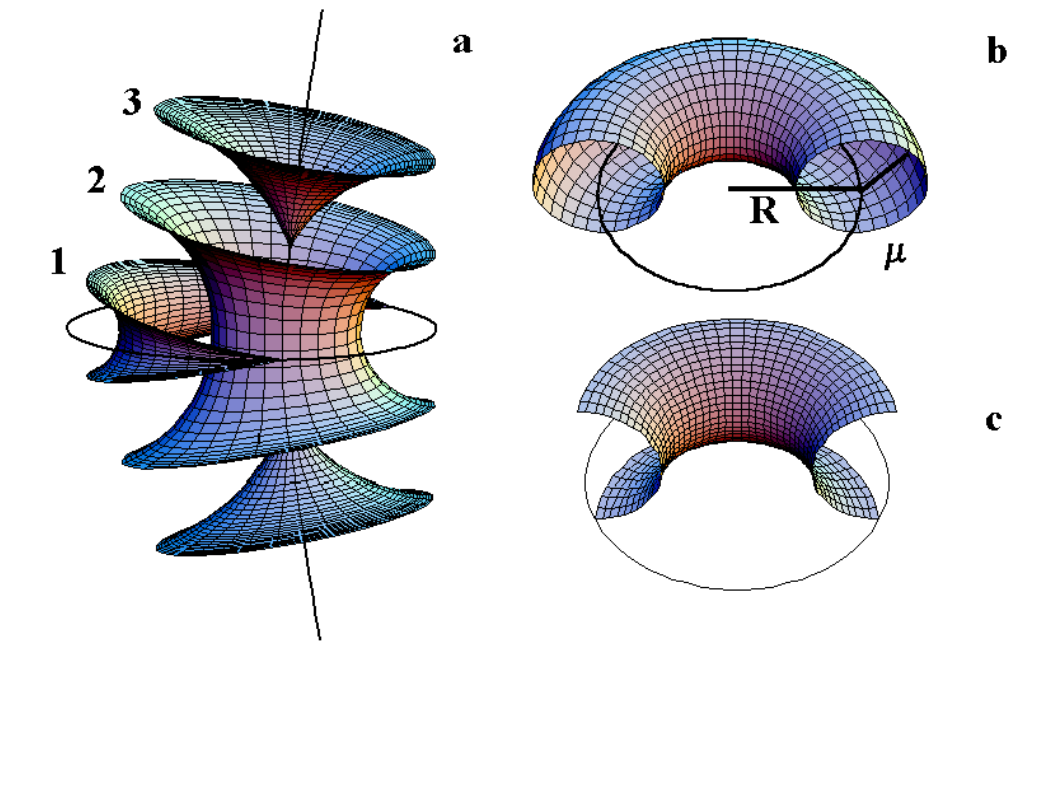
Figure 4. (a): three kind of layers for FCD of the first species; (b): representation of a torus: R being the radius of the directing circle and µ the radius of the generating circle; (c): representation of a TFCD (Toric Focal Conic Domain) with some negative Gaussian